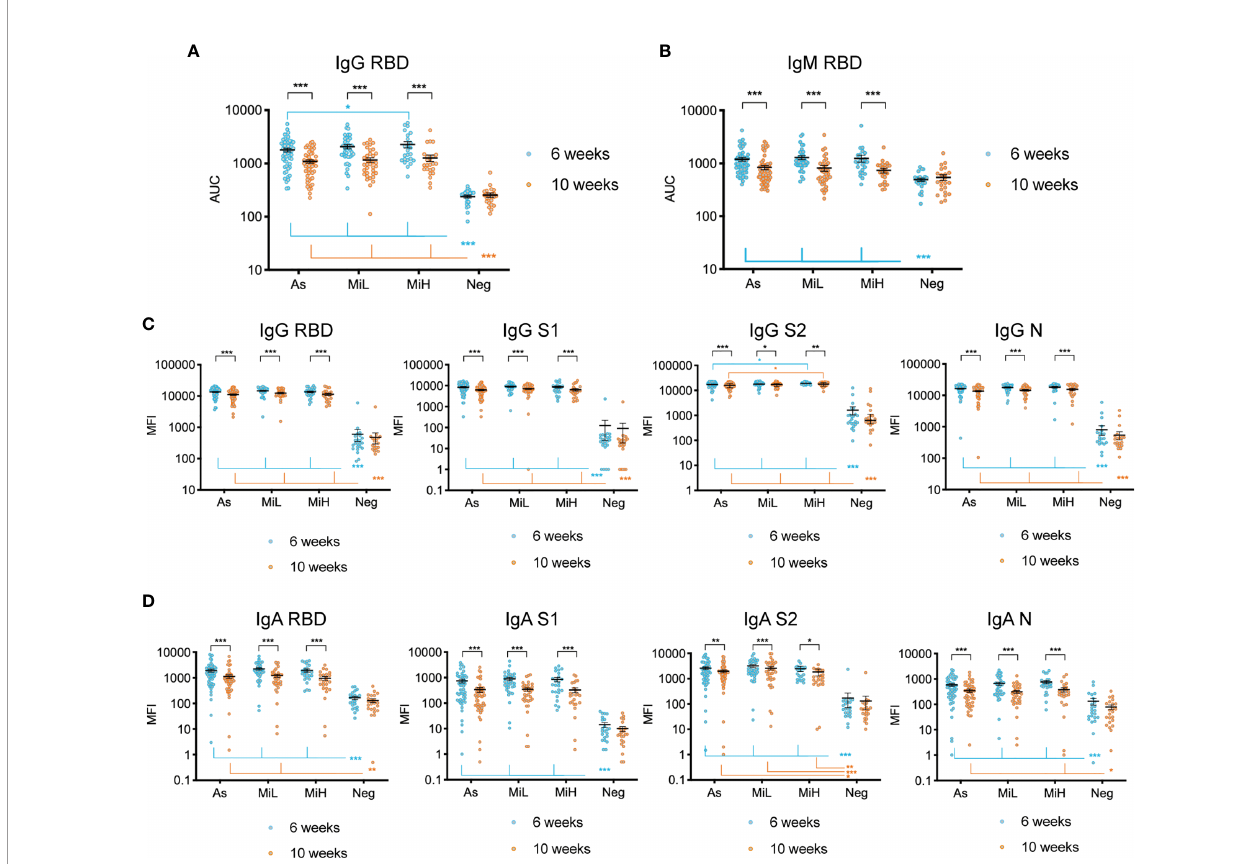
FIGURE 1 | Evaluation of IgG and IgM antibodies against SARS-CoV-2 RBD by ELISA (A, B) , and of IgG (C) and IgA (D) antibodies directed towards SARS-CoV-2 RBD, S1, S2 and N using Luminex xMAP-based multiplex assay in samples from 137 participants (As n=53; MiL n= 36; MiH n= 25, Neg n=23). Mean and SEM are indicated. AUC, Area Under the Curve; MFI, Mean Fluorescence Intensity. Two-way ANOVA test followed by multiple comparisons with Benjamini-Hochberg method (desired FDR 0.05). Adjusted p-values *< 0.05; **< 0.01; ***< 0.001.